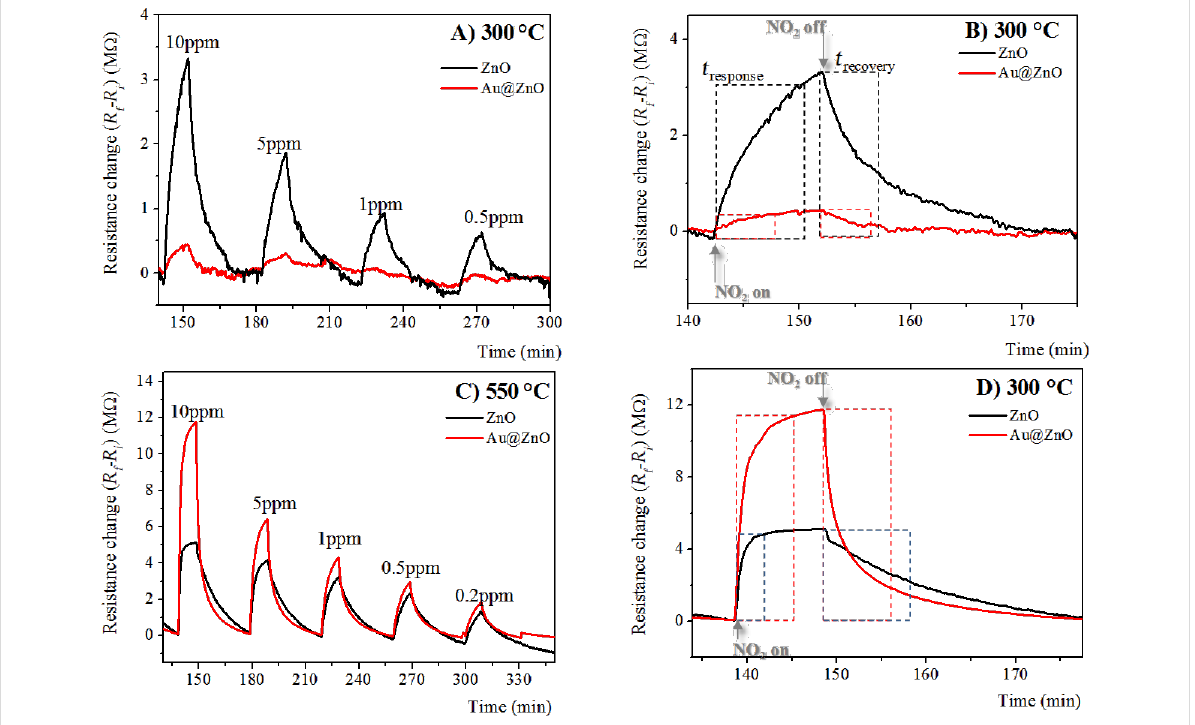
Figure 4: A) Time response of chemiresistors based on pristine and Au-doped ZnO annealed at 300 °C, exposured to different NO 2 concentrations [0.5–10 ppm] at operating temperature of 300 °C; B) enlarged parts of the dynamic response curve shown in a at a NO 2 concentration of 10 ppm drawn to reveal the moments of gas input and gas stop. C) time response of chemiresistors based on pristine and Au-doped ZnO annealed at 550 °C, exposed to different NO 2 concentrations [0.2–10 ppm] at an operating temperature of 300 °C; D) enlarged parts of the dynamic response curve